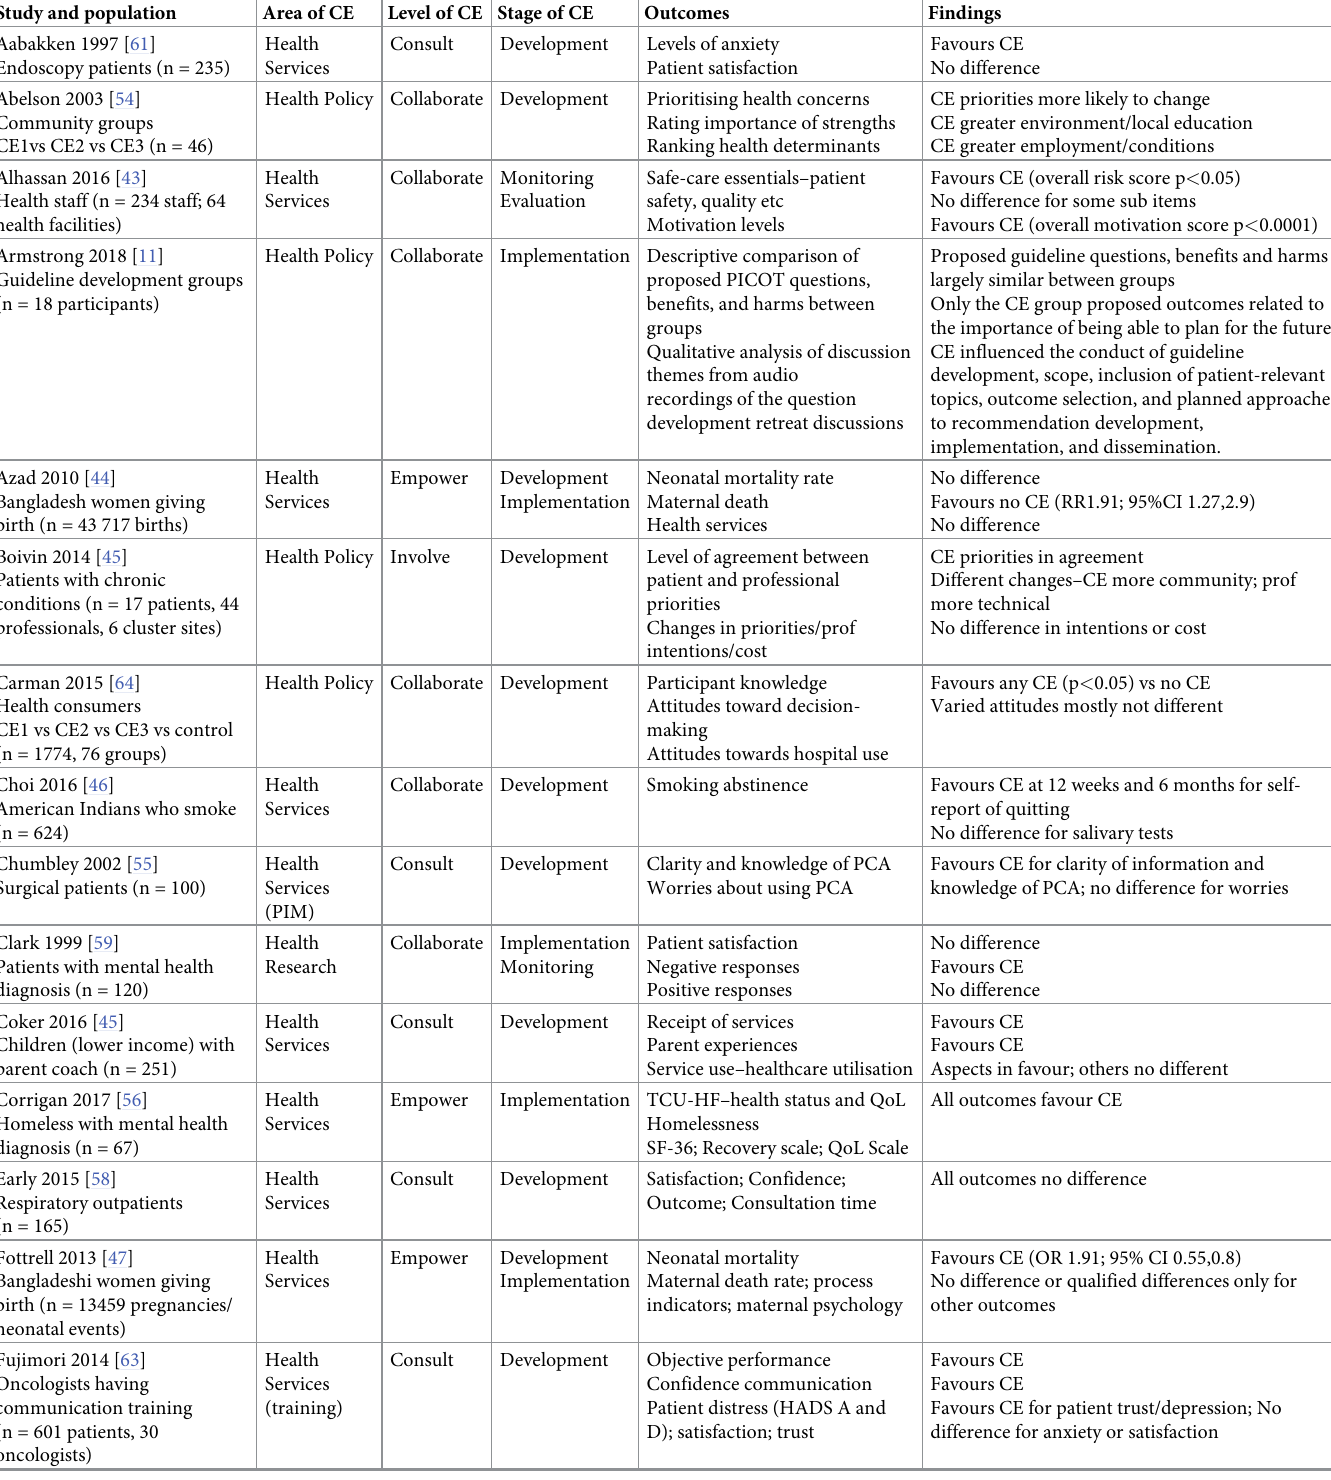
Table 2. Results–included trials, with summary of population, intervention details, comparisons, outcomes and